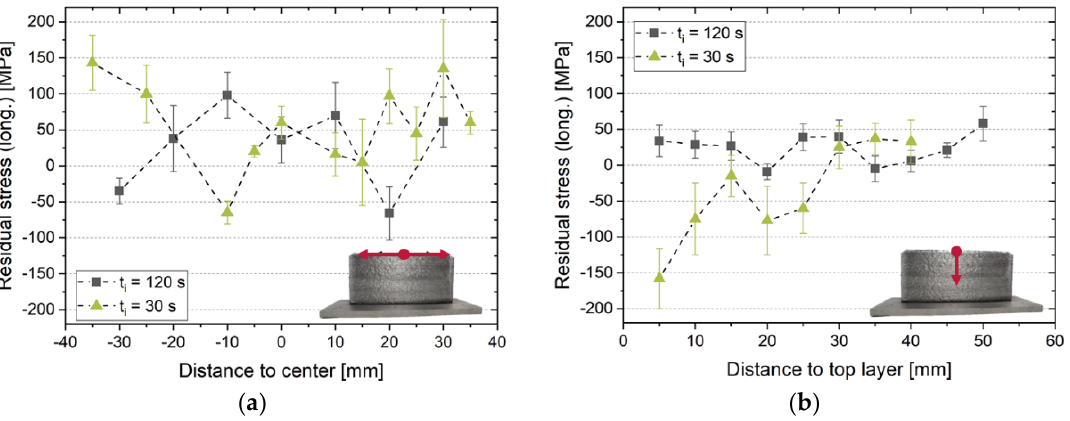
Figure 7. Residual stress in welding ( a ) and building ( b ) direction (Series A).